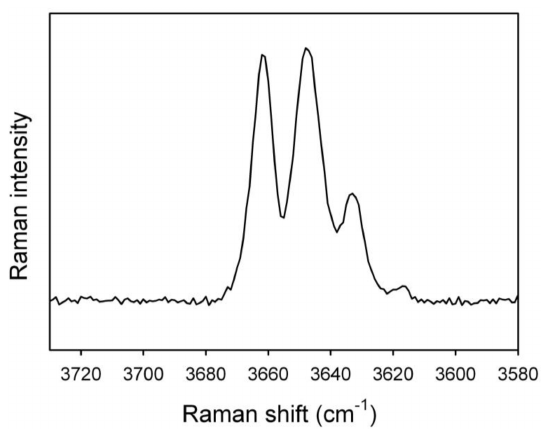
Figure 6. Raman spectrum of the studied glaucophane in the OH- stretching region.